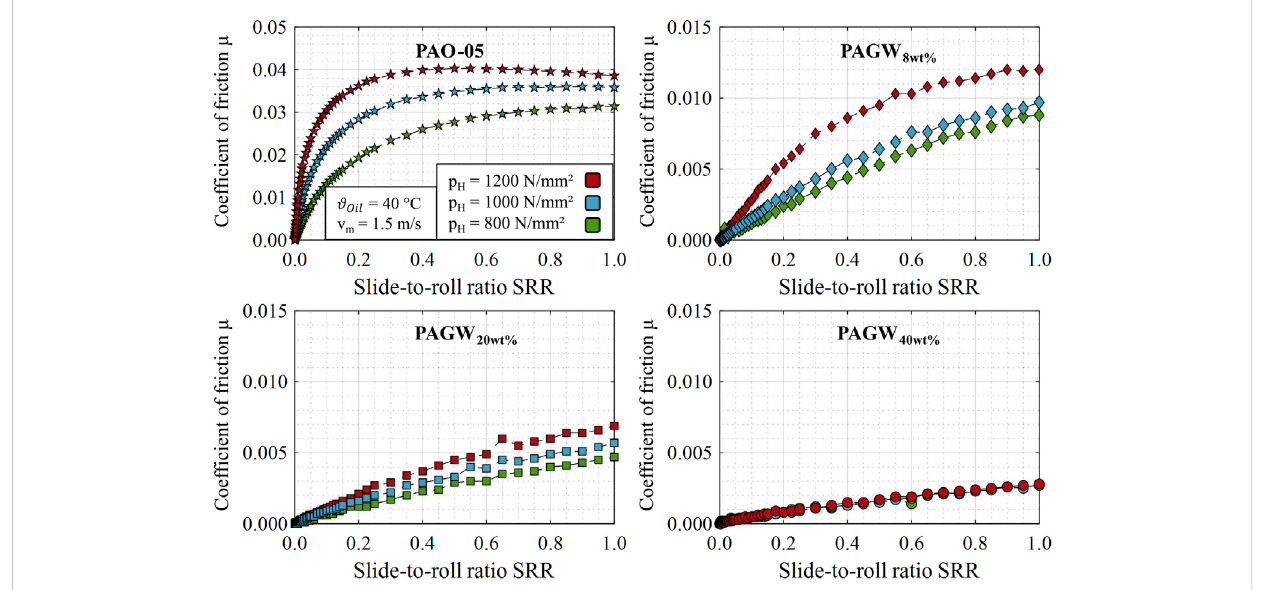
FIGURE 4 Friction curves for varying contact pressures of p H = {800; 1000; 1200} N/mm 2 at v m = 1.5 m/s and ϑ Oil = 40 ° C in comparison of the investigated